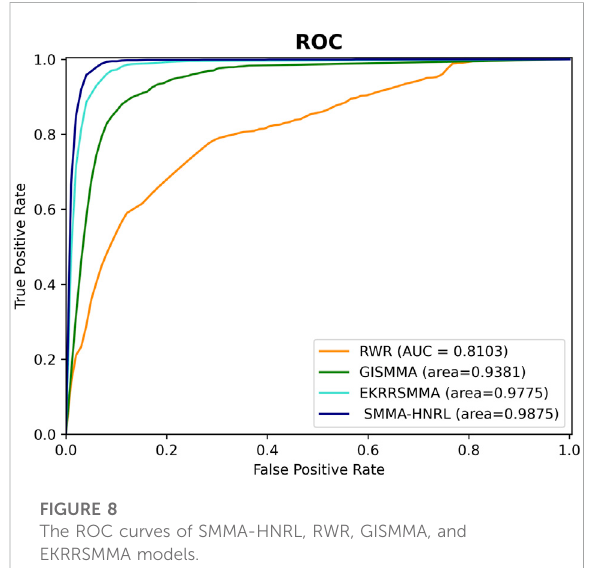
FIGURE 8 The ROC curves of SMMA-HNRL, RWR, GISMMA, and EKRRSMMA models.